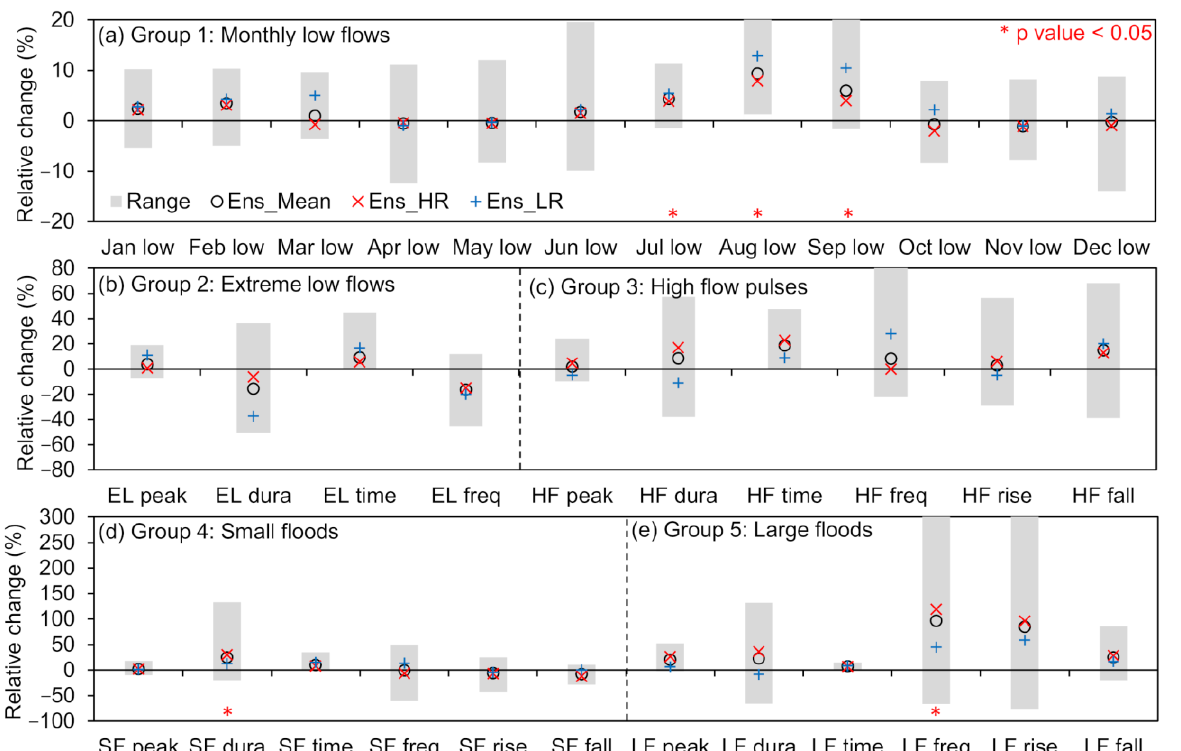
Figure 7. Projected changes in hydrological extremes as indicated by 32 EFC parameters of ( a ) monthly low flows, ( b ) extreme low flows, ( c ) high flow pulses, ( d ) small floods and ( e ) large floods between 1985–2014 and 2021–2050 at the Jambatan Guillermard station.